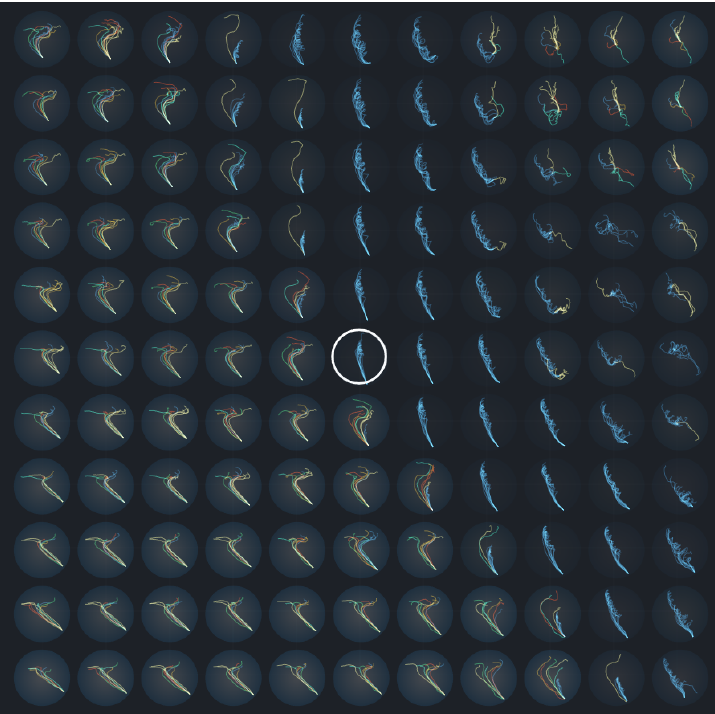
Figure 9. Comparison view of marked location “B” in Figure